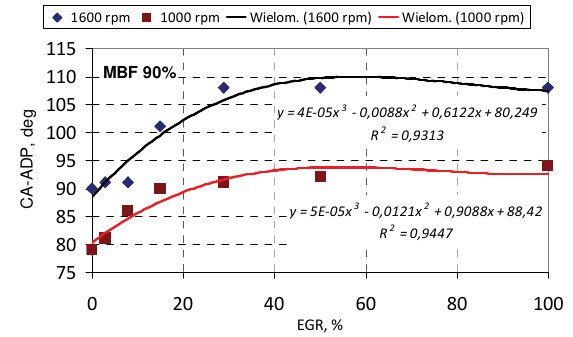
Fig. 14. Impact of EGR opening at MBF 90% value 190 Nm load)